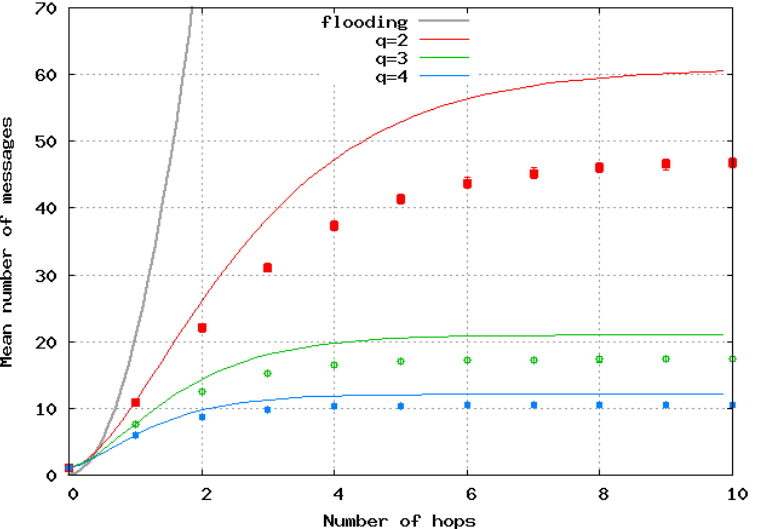
Figure 7. Mean number of messages sent per location update with respect to number of hops in 2D homogeneous